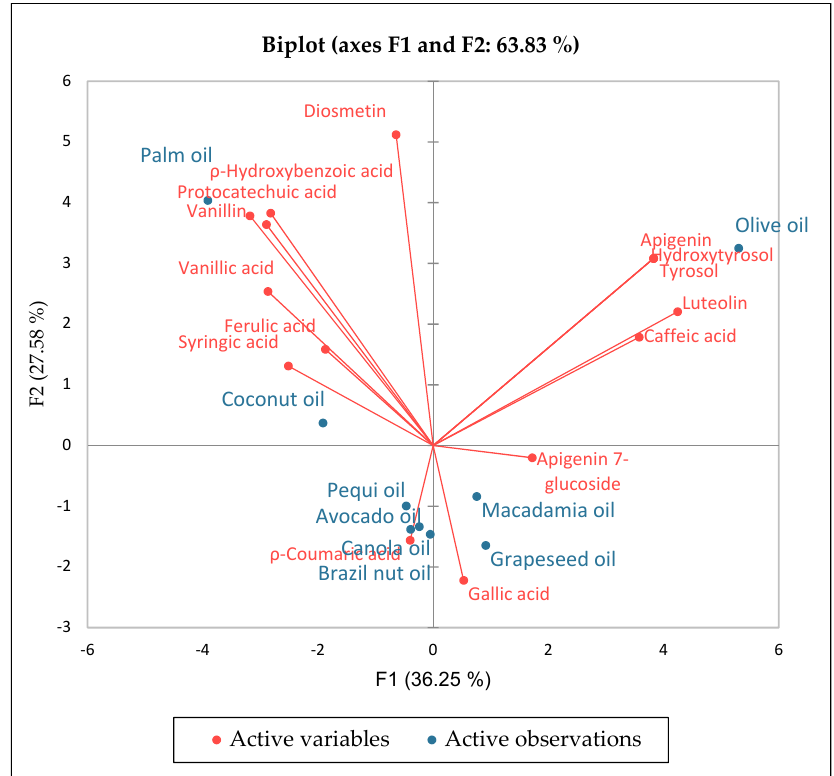
Figure 6. Principal component analysis showing a comparison of phenolic compounds in coldpressed macadamia nut oil and other selected cold-pressed oils. Adapted from Cicero et al.